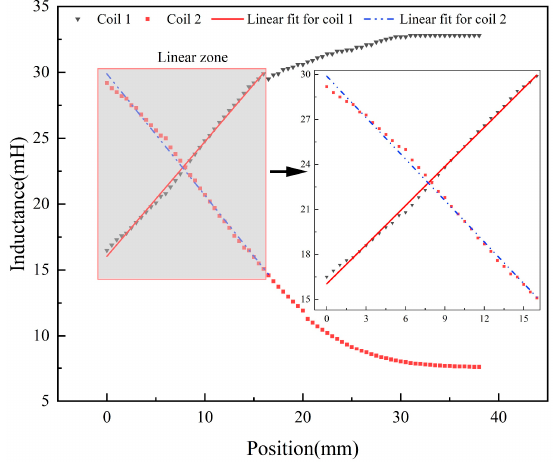
Figure 12. The relationship between coil inductance and core position in DIPT16. Table 1. The linear fit results of the coil inductance.